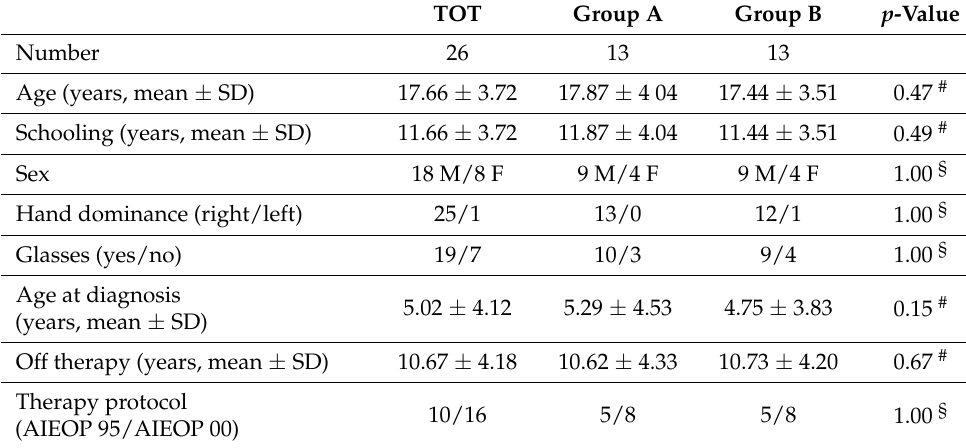
Table 1. Demographics of the enrolled